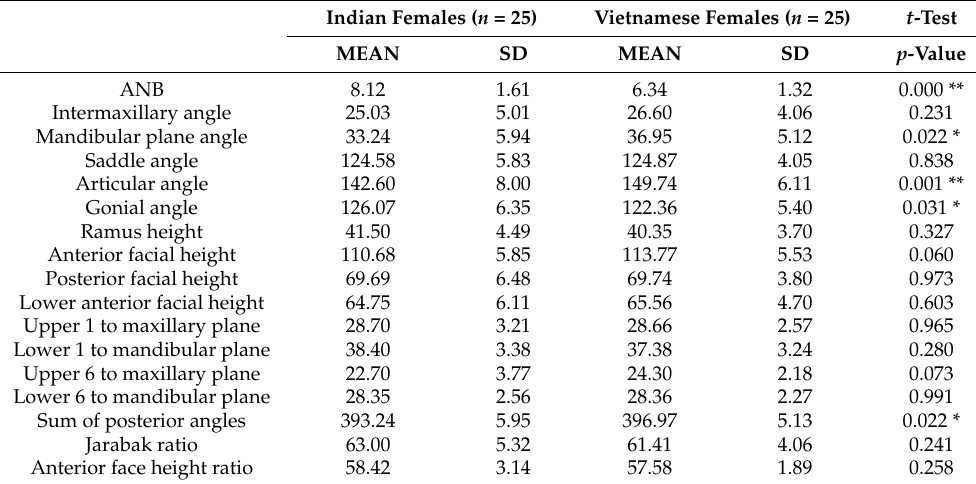
Table 3. Comparison of cephalometric parameters between the South Indian and Vietnamese females. Parameters with statistically significant differences between means ( p < 0.003) are marked with two asterisks, while borderline statistically significant results ( p < 0.05) are marked with one asterisk. Indian Females ( n = 25) Vietnamese Females ( n = 25) t -Test MEAN SD MEAN SD p